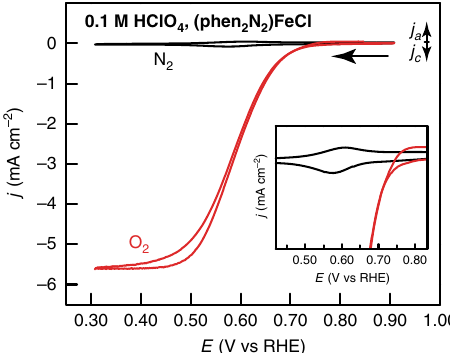
Fig. 6 Cyclic voltammograms of adsorbed (phen 2 N 2 )FeCl. A rotating glassy carbon disk electrode modi fi ed with a catalyst fi lm containing (phen 2 N 2 )FeCl in N 2 - (black) and O 2 - (red) saturated 0.1 M HClO 4 aqueous electrolyte. Data were recorded at 5 mV s − 1 and 2000 rpm rotation rate.